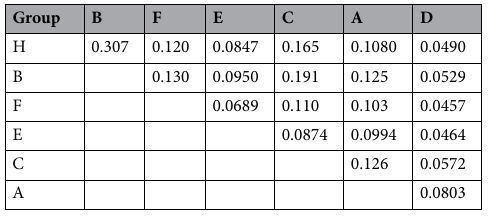
Table 2. Fst values for each pair of groups for A, B, C, D, E, F, H.